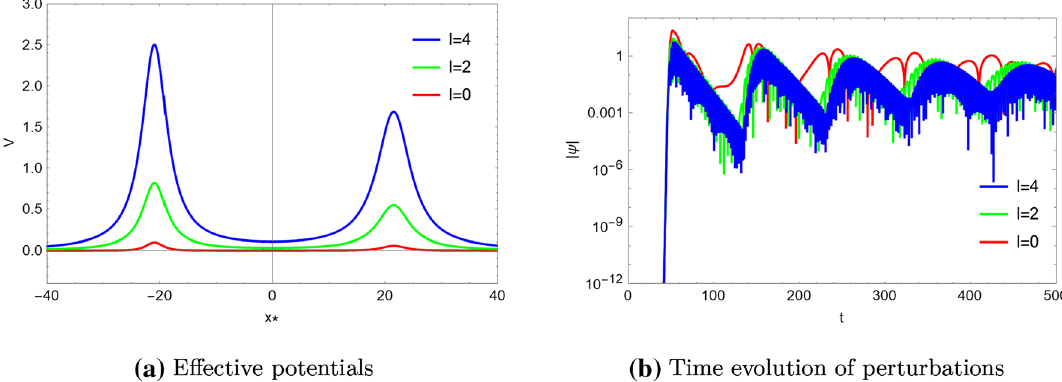
Fig. 3 The effective potentials and the corresponding time evolution profiles with different l . We set q = 1 . 6 ,γ 1 = − 10 ,γ 2 = 2 , Q = 1